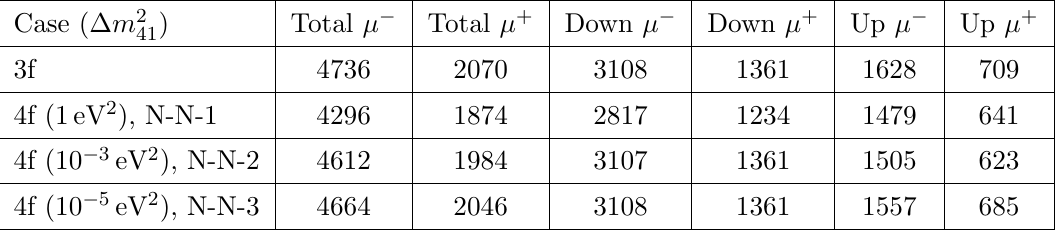
Table 3 . Number of events for 500 kt-yr exposure of ICAL, for E (cid:22) 2 [1 ; 11] GeV and NH in the active sector. We have taken j U e 4 j 2 = 0 : 025, j U (cid:22) 4 j 2 = 0 : 05, and j U (cid:28) 4 j 2 = 0. The information on hadron energy is not used. For sterile neutrinos, the results have been shown for three